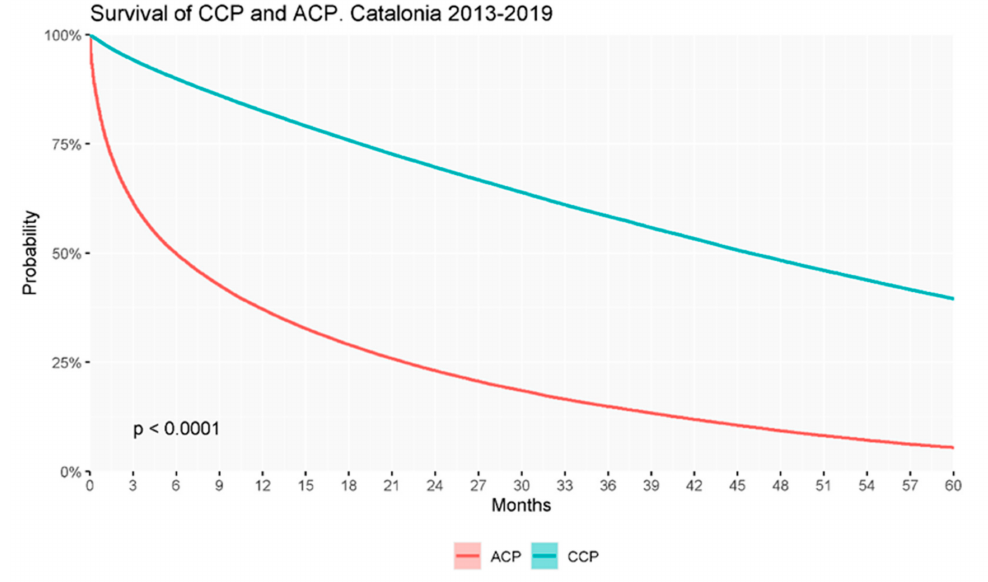
Figure 3. Probability of survival up to 5 years of the overall population of chronic complex patients and advanced chronic patients identified throughout the study period (2013–2019).